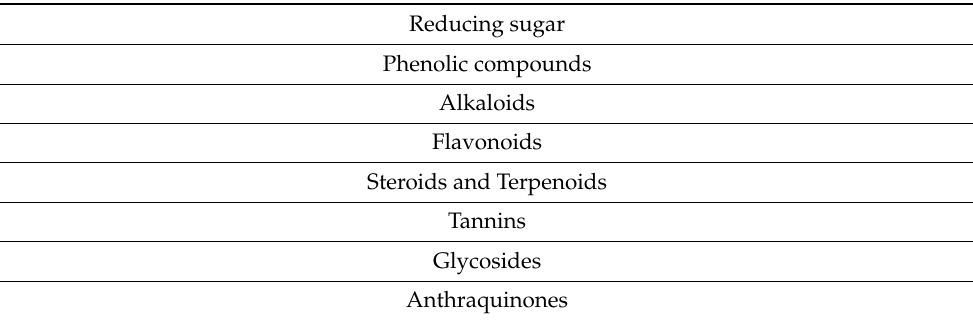
Table 2. Qualitative analyses of the phytochemical components of Aloe vera